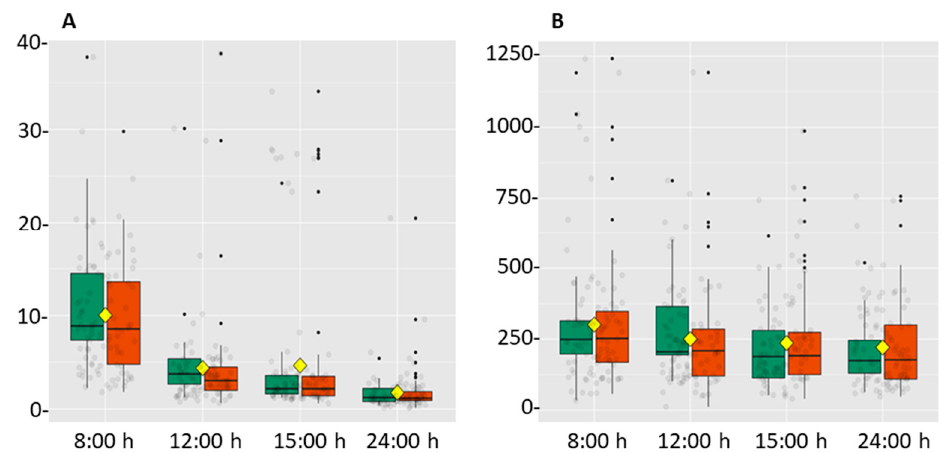
Figure 1. Box diagram of the pattern followed by salivary cortisol ( A ) and DHEA ( B ) throughout the working day according to gender. Green boxes correspond to men and red boxes to women. Hormone levels are represented by arbitrary values. The yellow square corresponds to the mean value, taking into account both genders. Black and grey dots represent the data distribution.